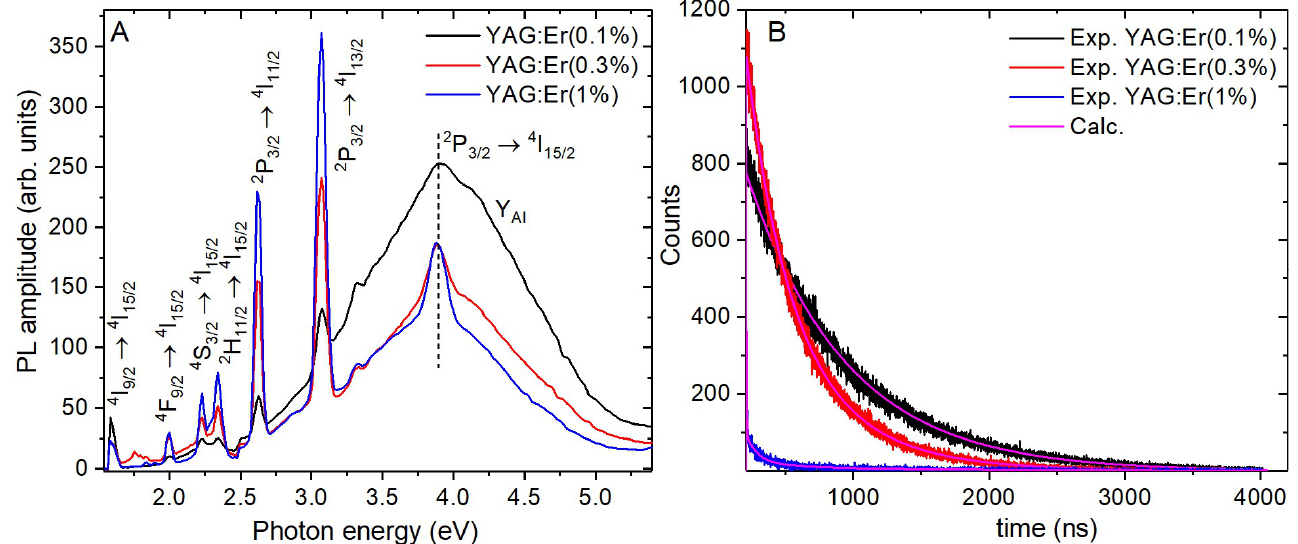
Figure 5. ( A ) RL spectra measured at 296 K under X-ray excitation in the YAG:Er (0.1%, 0.3% and 1%) samples. Specific Er 3+ transitions are indicated. ( B ) Decay curves measured at 296 K in the YAG:Er (0.1%, 0.3% and 1%) samples.